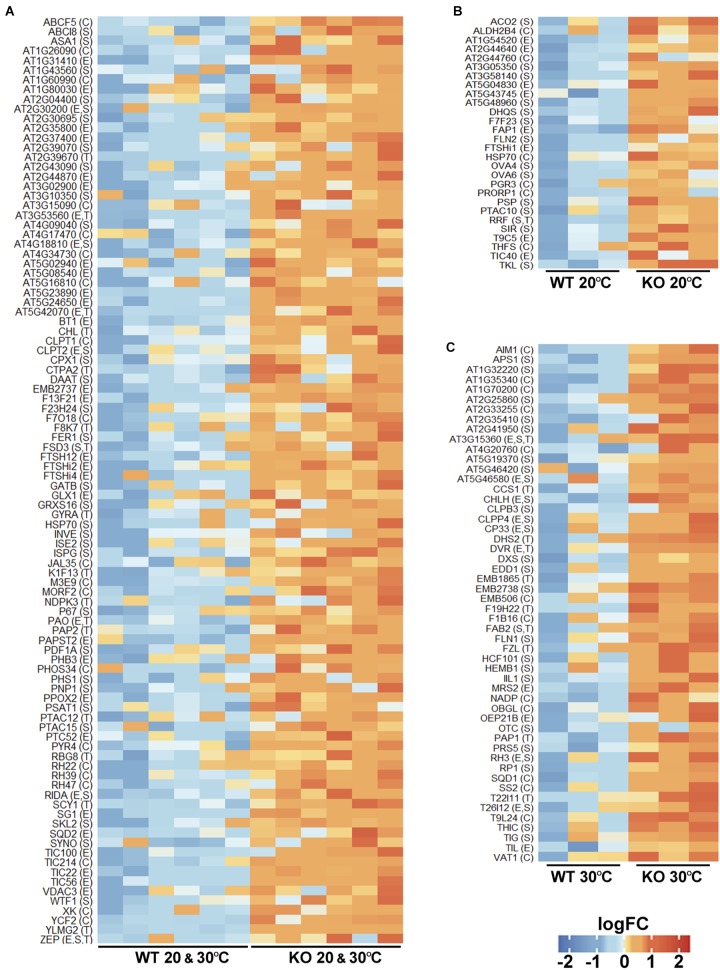
Chloroplast proteins upregulated in the FTSH11 KO mutant. Chloroplasts upregulated proteins were selected from the differentially expressed proteins presented in Figure 5. (A) Proteins that were upregulated both at 20°C and following exposure to 30°C for 6 h. (B) Proteins that were upregulated only at 20°C. (C) Proteins upregulated in the mutant only after exposure to 30°C. Protein names are denoted on the left of each panel. Intra-organelle localizations are in parentheses. C, chloroplast; E, envelope; S, stroma; T, thylakoid.